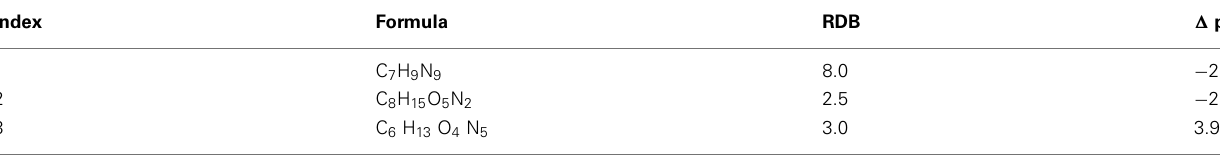
TableA3 | Chemical formulae calculated with m/ z 219.